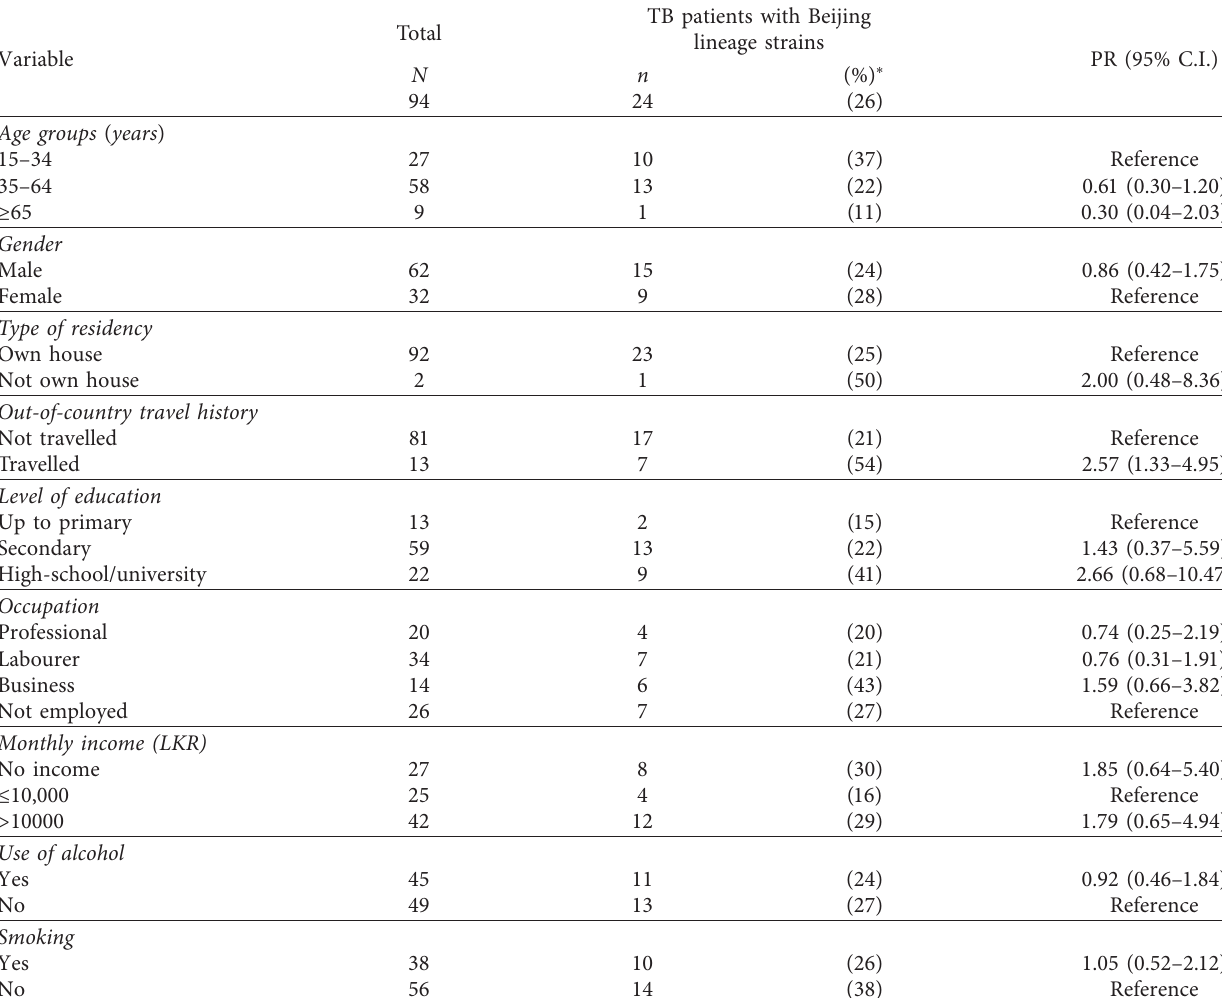
Table 1: Demographical, socioeconomic, and behavioural factors associated with Beijing lineage infection among TB patients diagnosed in a tertiary care hospital in Kandy, Sri Lanka, during February 2018–July 2019. TB patients with Total Variable